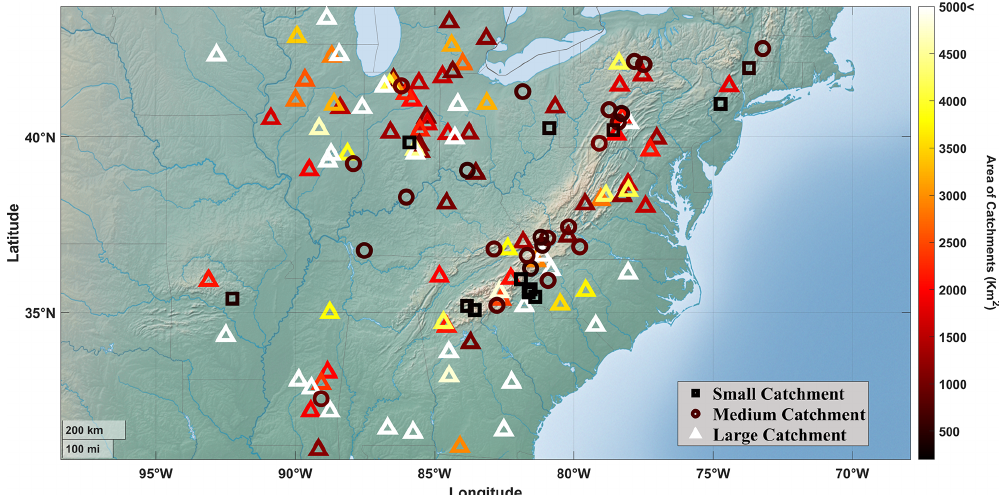
Figure 1. Distribution of catchments across the northeastern USA. Squares, circles, and triangles correspond to small, medium, and large catchments, respectively. Table 1. General characteristics of the three catchment-size groups. Number